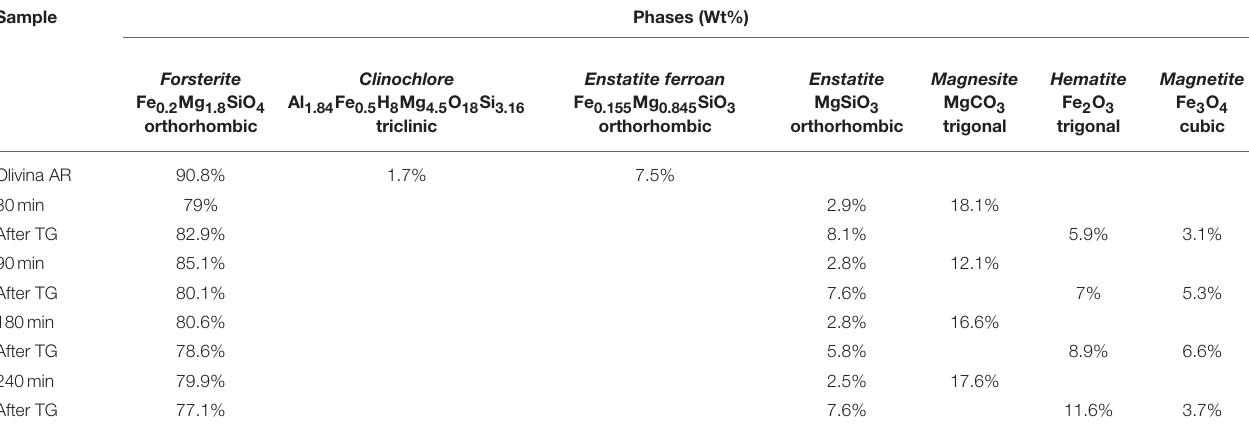
TABLE 3 | Phase composition, as evaluated by Rietveld analysis, of different samples after selected time of mechanical treatment, in the first series of tests. Sample